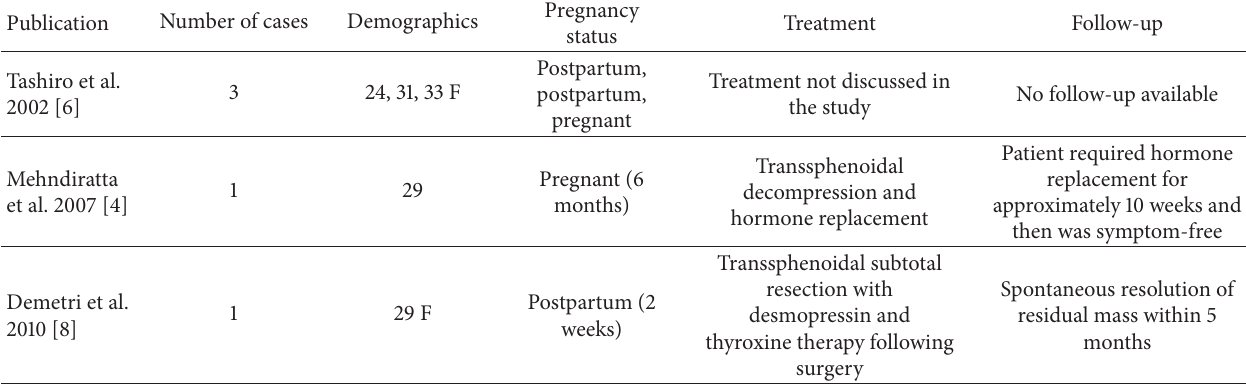
Table 2: Documented cases of postpartum idiopathic granulomatous hypophysitis with patient demographics and follow-up